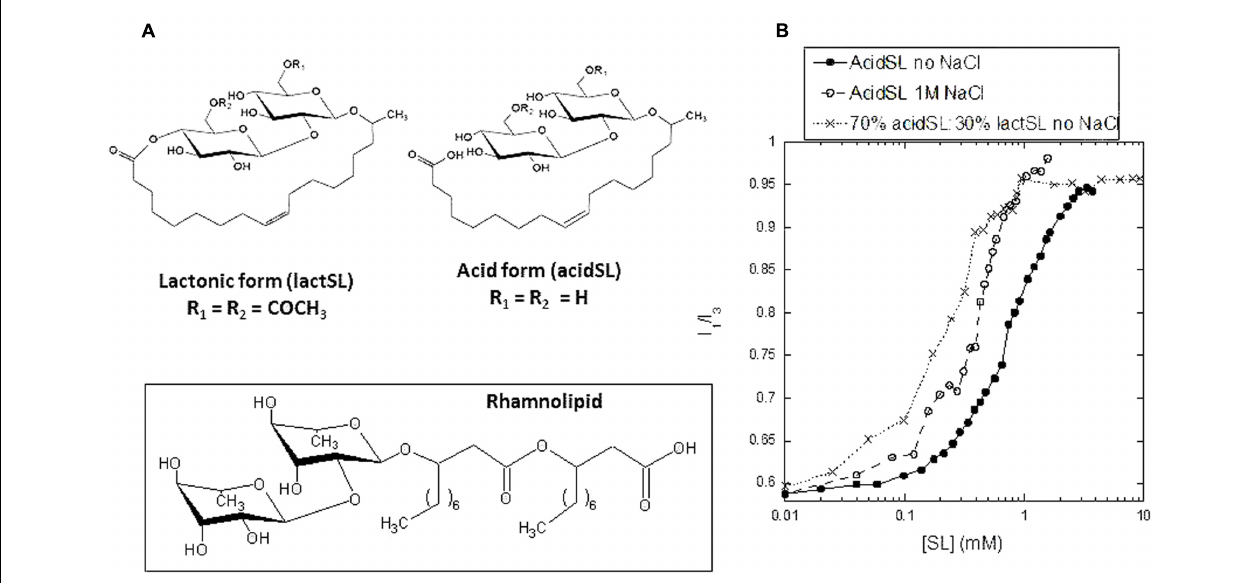
FIGURE 1 | (A) Structure of acidic and lactonic sophorolipids used in this study. The structure of rhamnolipid is shown for comparison. (B) Determination of the critical micelle concentration of pure acidSL and a mixture of 70% acidSL and 30% lactSL using pyrene